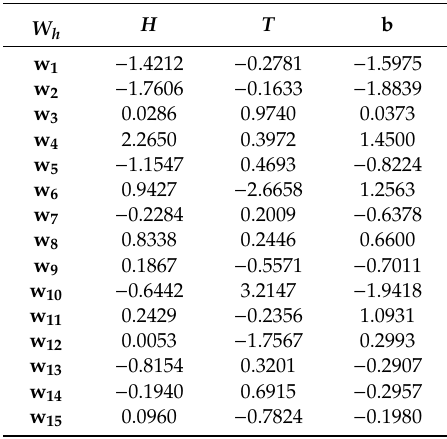
Table A1. Hidden synaptic weights of Gd ANN.